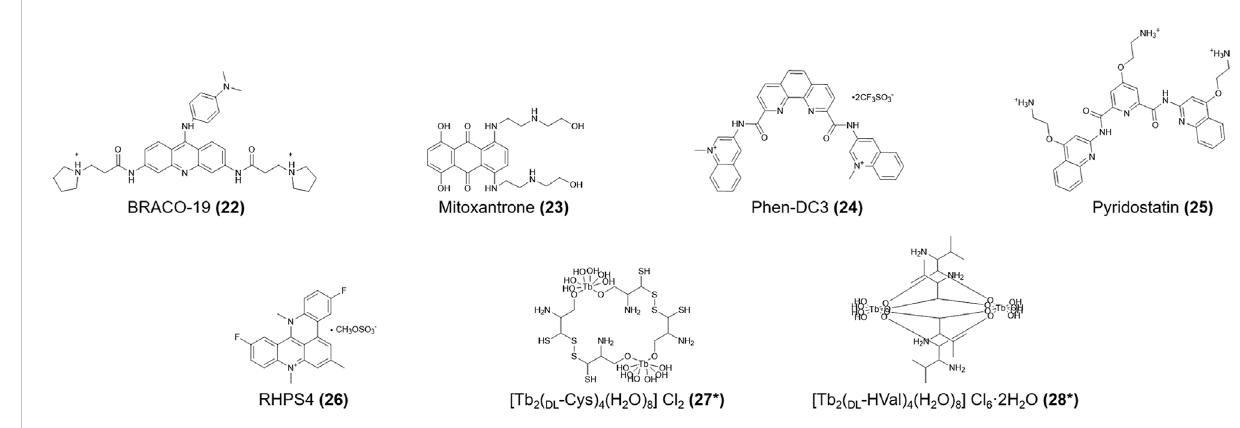
FIGURE 4 Structures of compounds ( 22 – 28 ). *Lattice water and chloride ions are